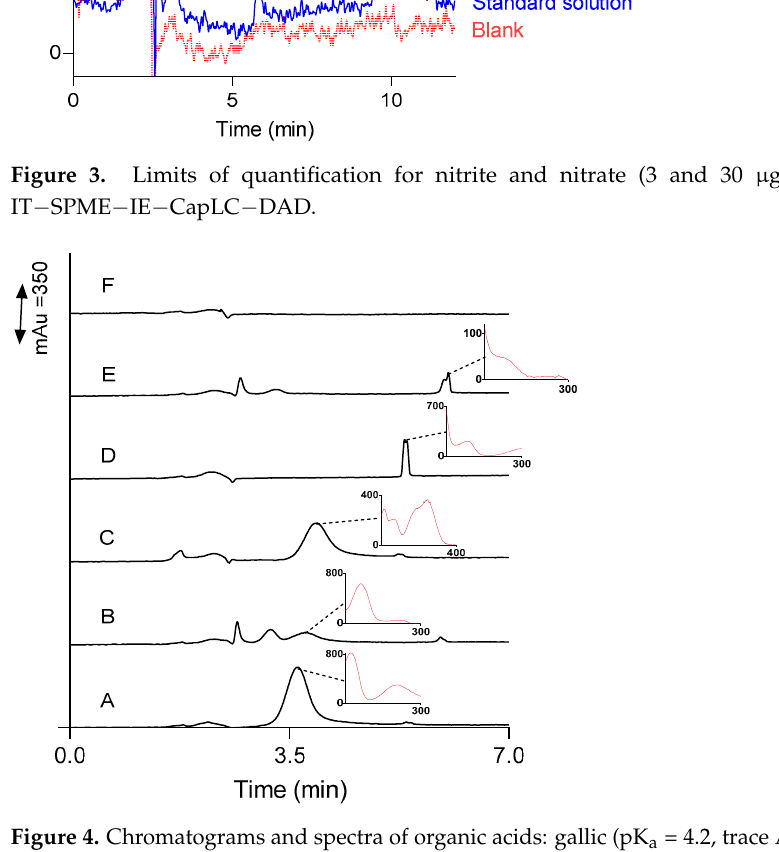
Figure 3. Limits of quantification for nitrite and nitrate (3 and 30 µg/L, respectively) by IT − SPME − IE − CapLC − DAD.